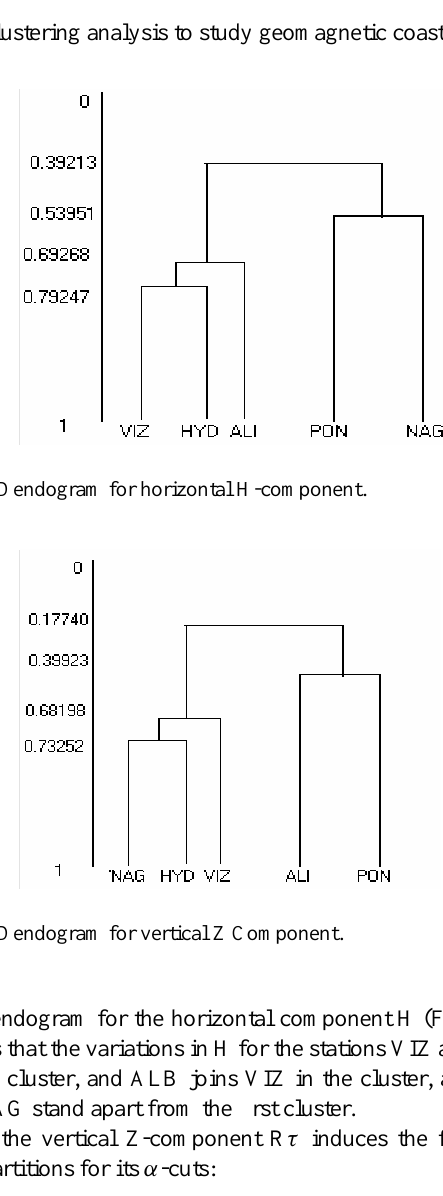
Figure 4. Dendogram for Declination D component Figure 5.